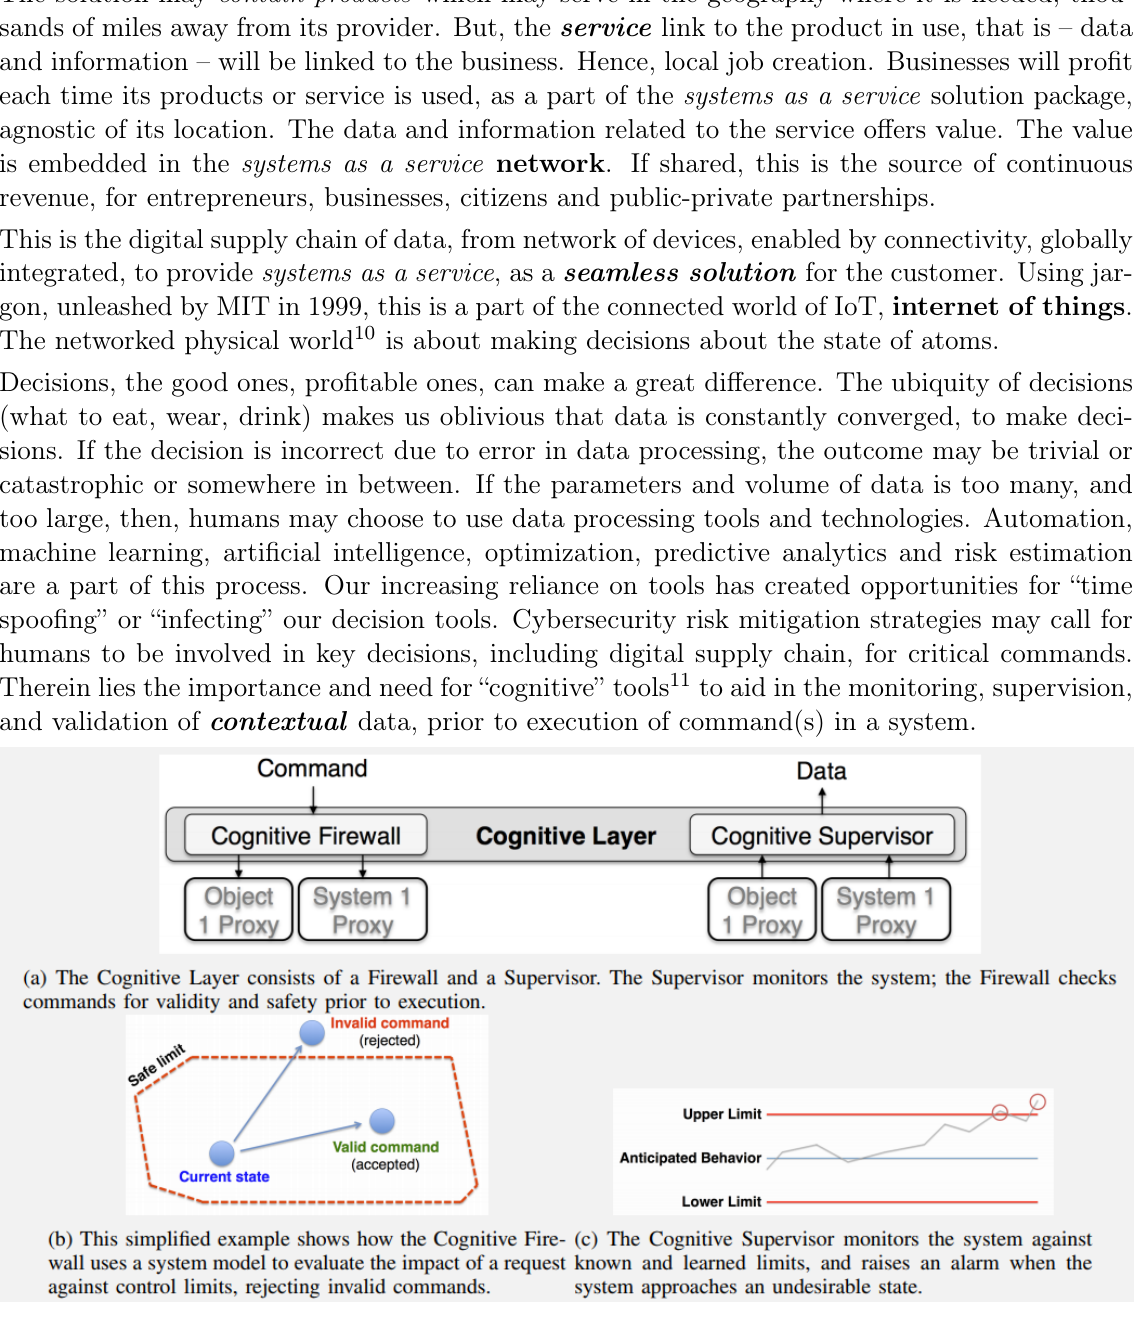
Fig. 3. The ‘cognitive layer’ in the digital copy 10 of the physical world - cognitive digital